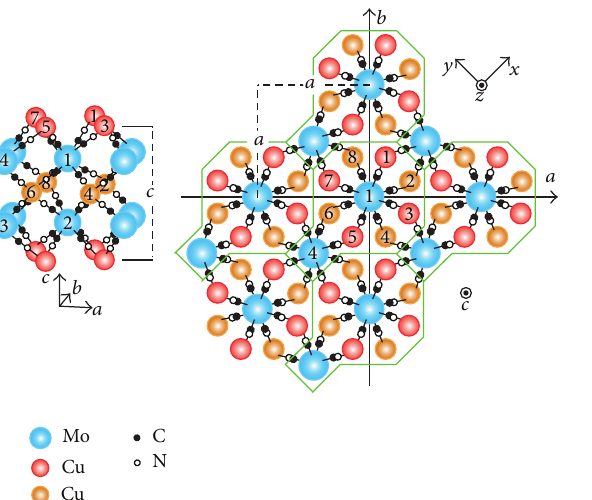
Figure 1: The cyano-bridged copper-molybdenum bimetallic assembly Cu 2 [ Mo ( CN ) 8 ] . Cu and Mo sites in each cell are labeled in this